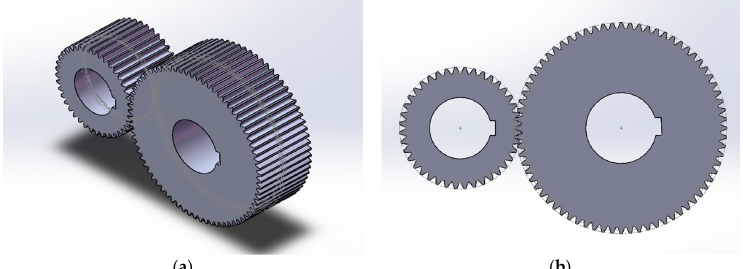
Figure 6. 3-D model of the gears under testing. ( a ) gear models in 3-D dimension; ( b ) .gear models in 2-D dimension. Gear parameters are provided in Table 1. Table 1. List of gear parameters for the tested gearbox.